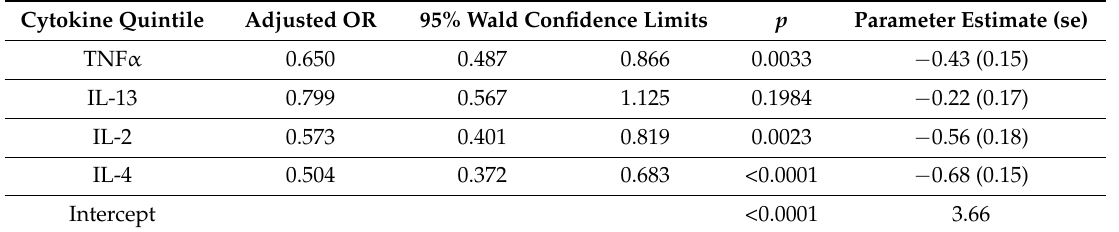
Table 2. The final logistic regression model for cytokines.